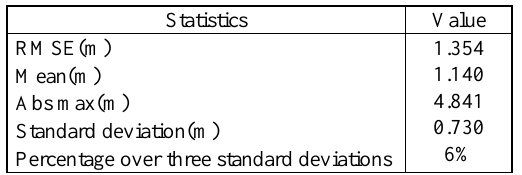
Table 2. Statistics of the difference between automatically and manually generated DEM from the region in Figure